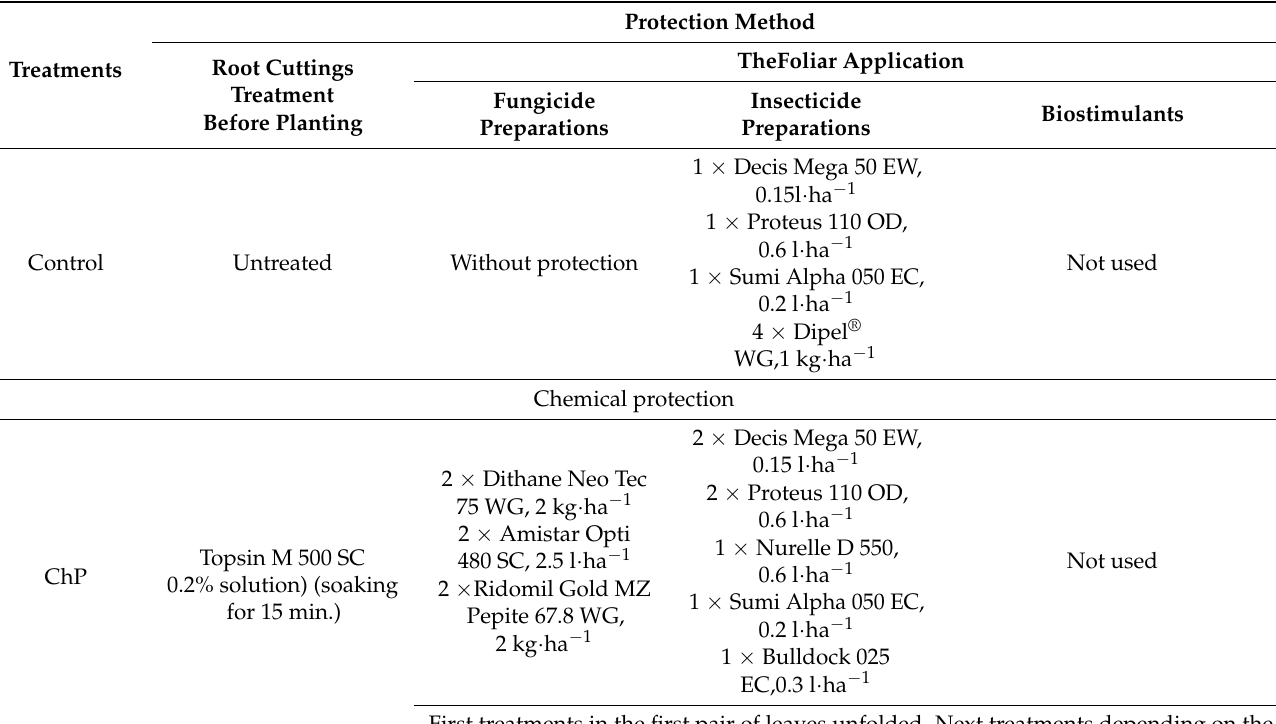
Table 1. Scheme of horseradish protection